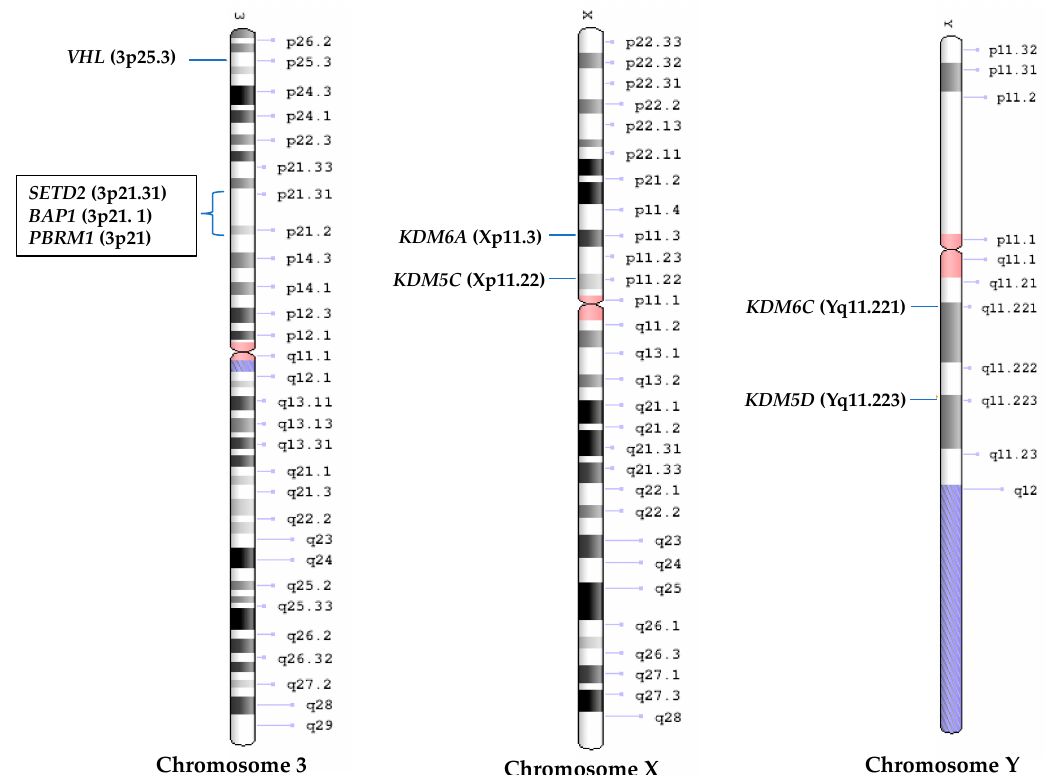
Figure 2. Location of frequently mutated or downregulated epigenome modifier genes including PBRM1 , BAP1 , SETD2 , KDM5C and KDM6A in ccRCC. Chromosome 3p contains a ~50 Mbs region where four of these TSGs are located next to each other. Moreover, KDM5C and KDM6A are located on X chromosome but escape X-inactivation (EXITS). KDM5D and KDM6C , that are located on the Y chromosome, are homologs of KDM5C and KDM6A respectively. Interestingly, these chromosome Y homologs of the X-lined genes are commonly deleted in male patients affected by ccRCC. Figure not drawn to scale. Pink, Centromere; Black, G-positive band; White, G-negative band; Gray, G-positive band (with increasing gray color intensity indicating increasing positive band 25–75%); and Purple, variable region.